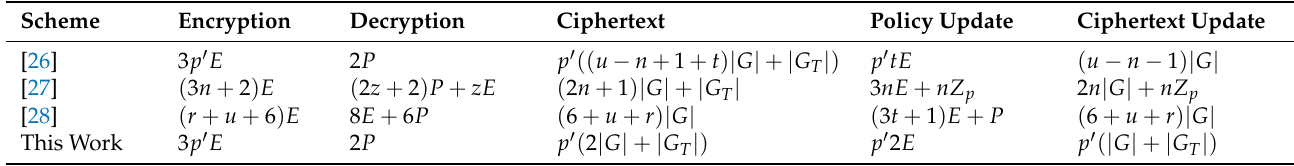
Table 5. Comparison of schemes based on policy